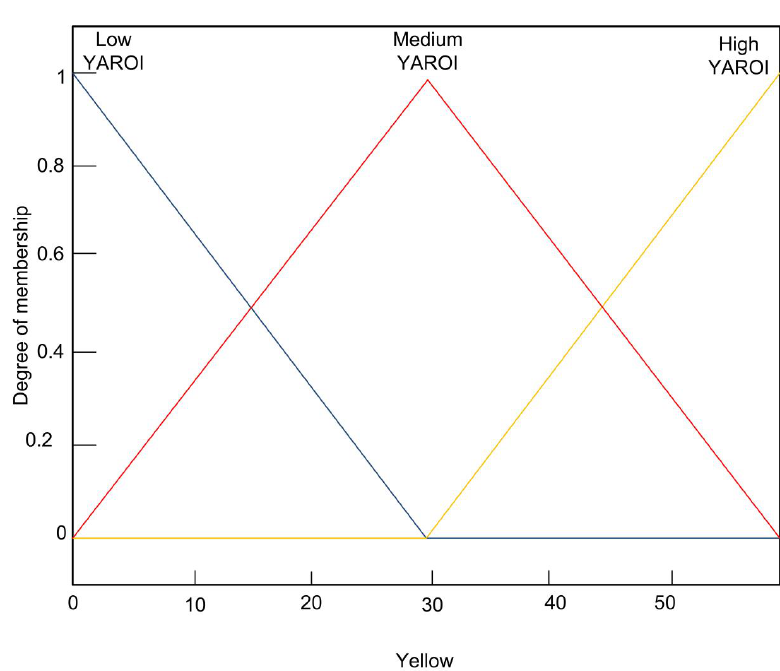
Figure 12 Figure 12. Membership functions of YAROI